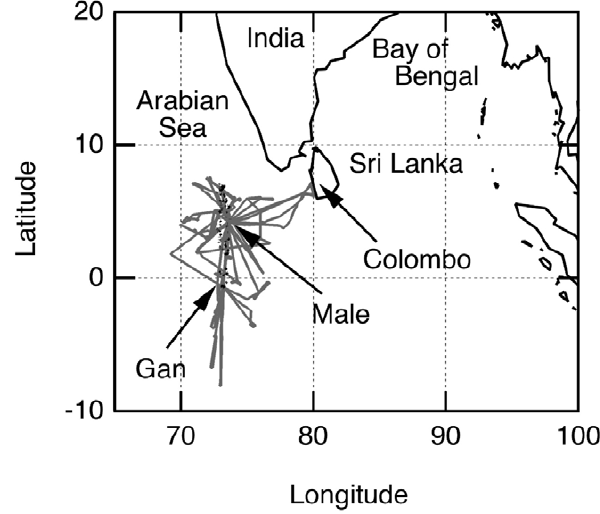
Fig. 13. Flight tracks of the Dutch Cessna Citation during the IN- DOEX intensive field phase (IFP) (from de Gouw et al., 2001, copy- right 2001 by the American Geophysical Union, reproduced with